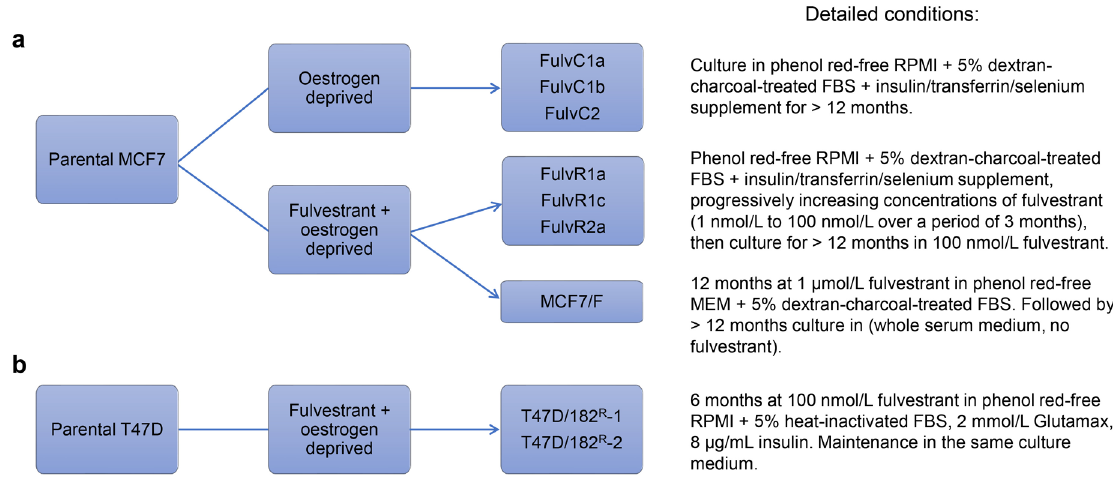
Figure 2. Summary of conditions used to generate fulvestrant-resistant MCF7 (a) and T47D (b) sublines by Liu et al. [35],